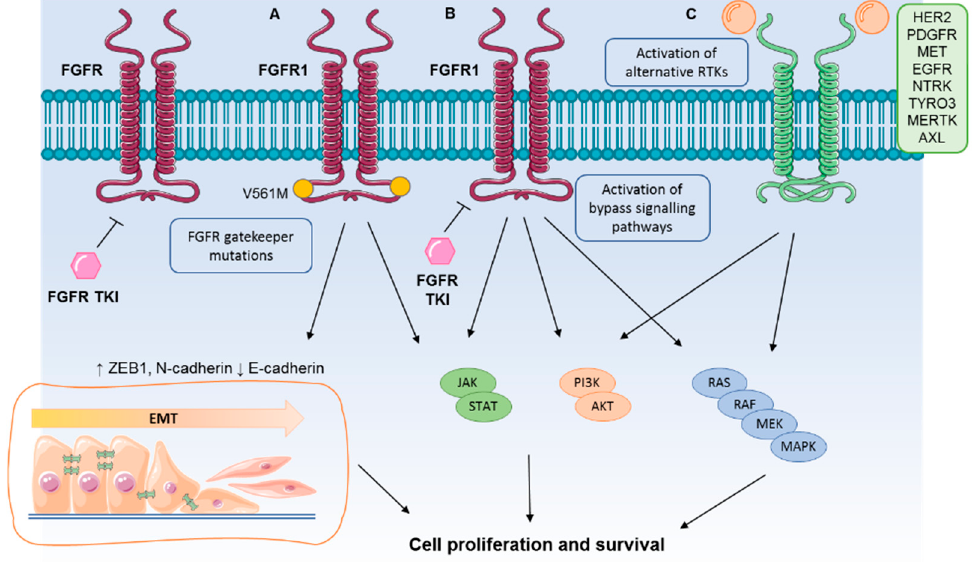
Figure 2. Mechanisms of acquired resistance to FGFR TKIs in lung cancer cell models. Preclinical evidence from the use of FGFR inhibitors in lung cancer models suggests drug resistance occurs through the ( A ) acquisition of gatekeeper mutations in FGFR and epithelial to mesenchymal transi- tion, ( B ) activation of bypass signalling pathways such as JAK/STAT, PI3K/AKT and MAPK, and ( C ) activation of alternative RTKs.